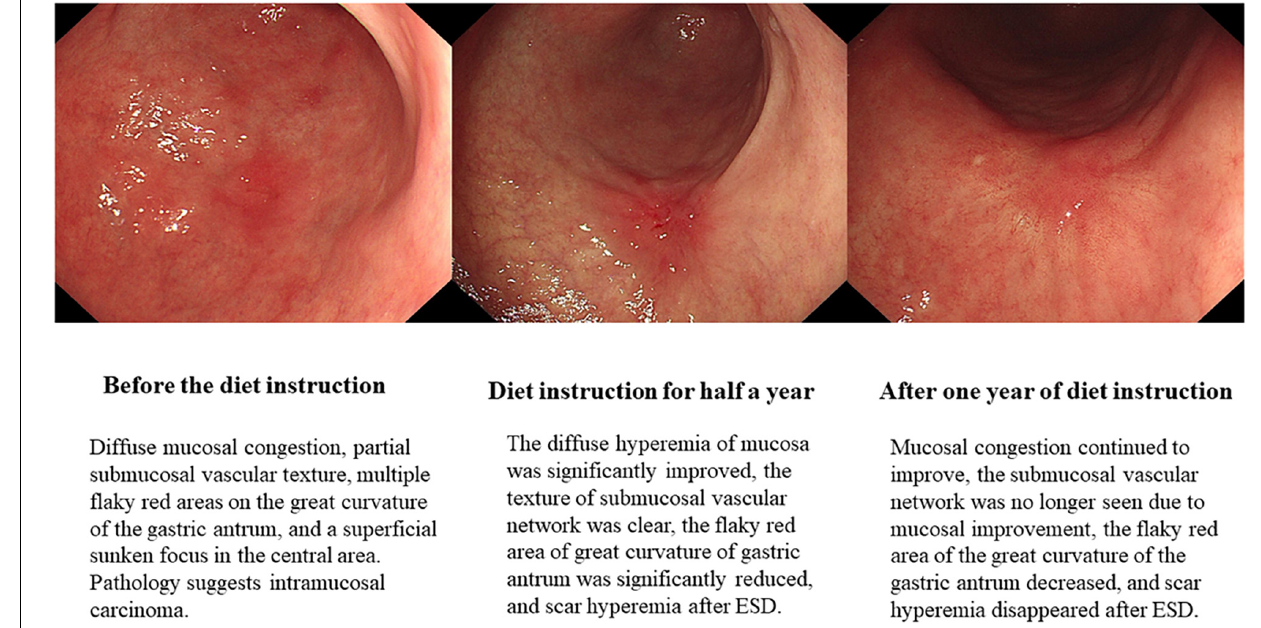
Frontiers in Nutrition |